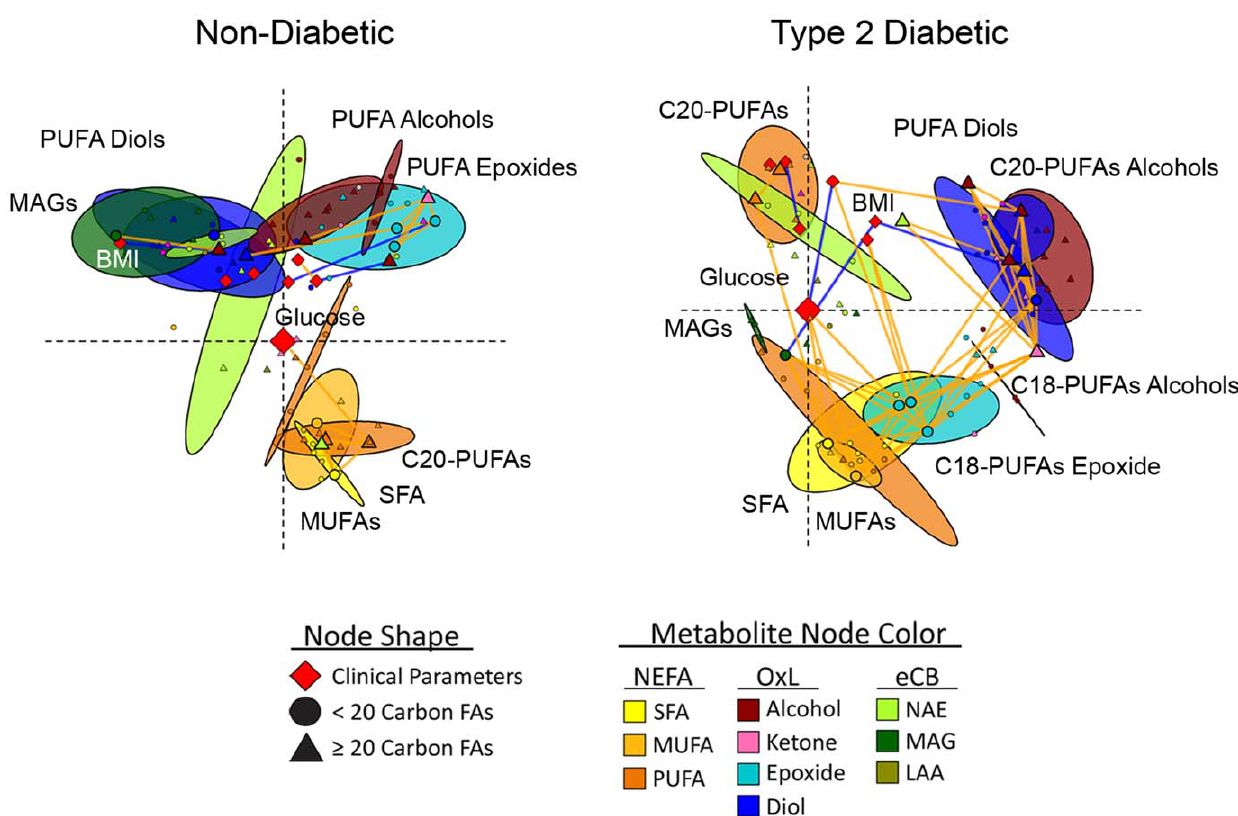
Figure 4. Parameter connectivity networks of metabolites and clinical parameters in African-American women with and without type 2 diabetes. Spearman’s correlations were used to generate multi-dimensionally scaled parameter connectivity networks for variable intercorrelations. Networks were oriented with fasting glucose at the origin and SFA in the lower right quadrant. Colored ellipses represent the 95% probability locations of metabolite classes (Hoettlings T 2 , p , 0.05). Nodes indicate clinical parameters (diamonds), , 20-carbon fatty acid metabolites (circles) and $ 20-carbon fatty acid metabolites (triangles), with discriminant model variables and glucose enlarged. Significant correlations between species are designated by orange (positive) or blue (negative) connecting lines (p , 0.05, non-diabetic; p , 0.01, diabetic participants).